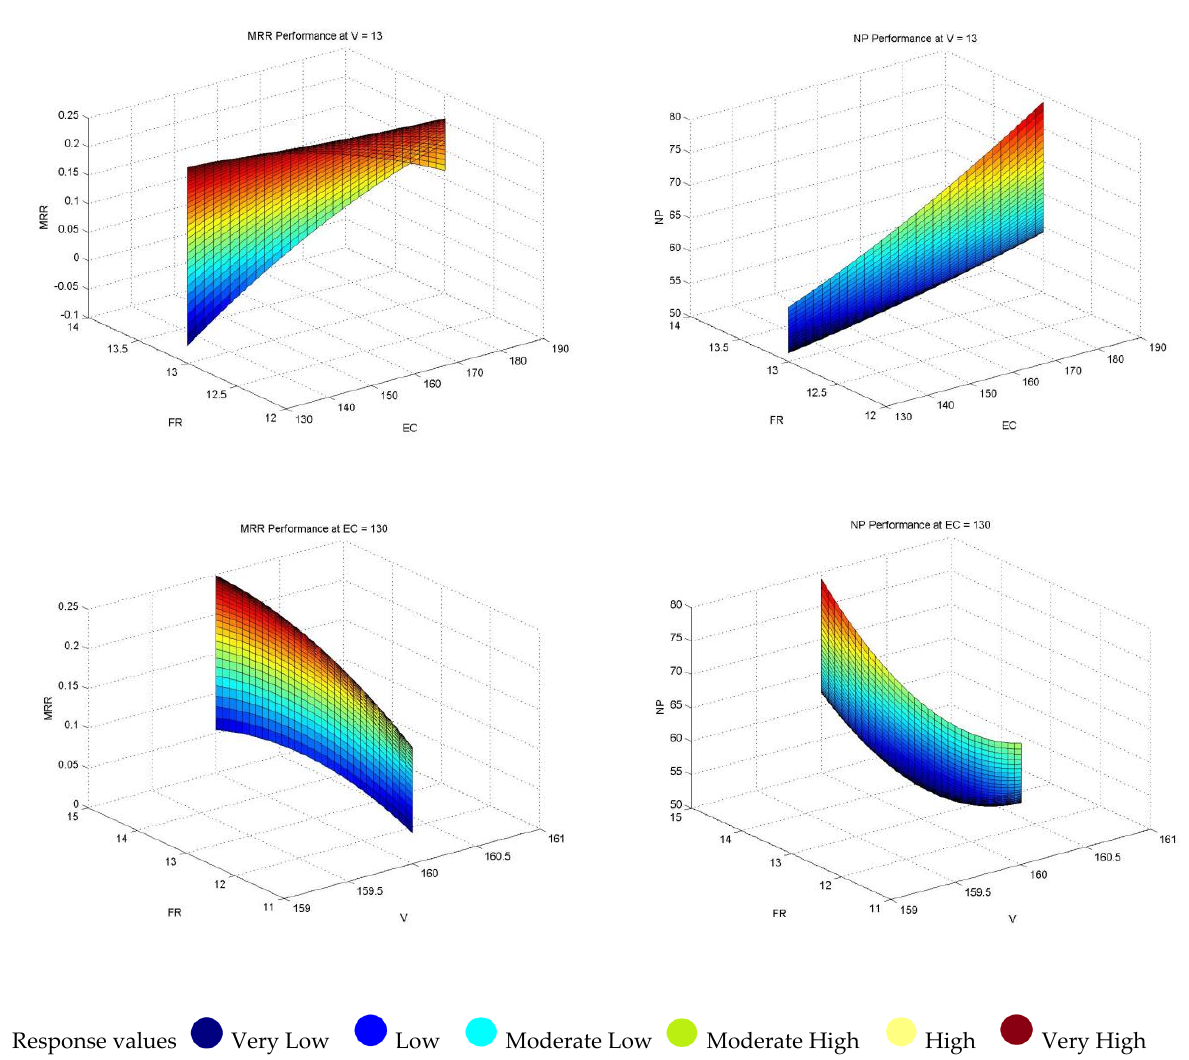
Figure 8. Surface plot of responses for various combinations of parameters.